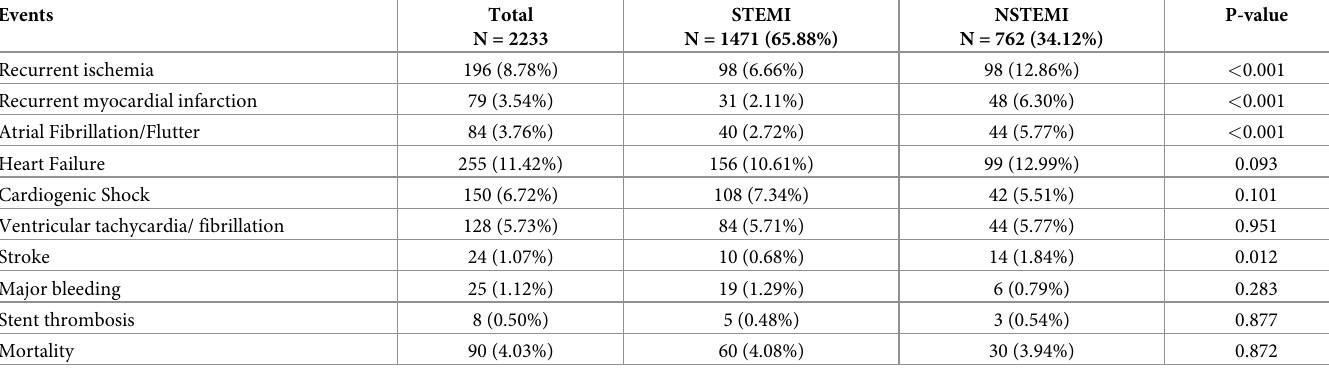
Table 2. In-hospital course and outcomes of patients with acute myocardial